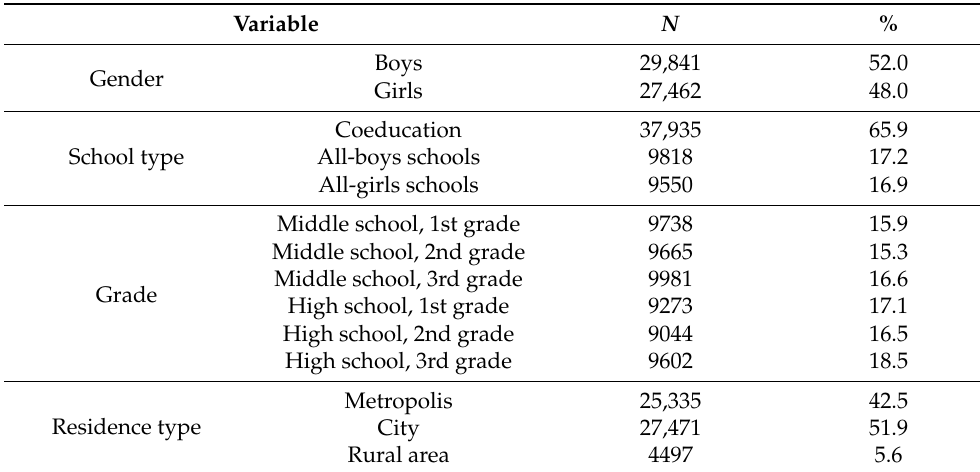
Table 1. General characteristics of the study subjects ( n =